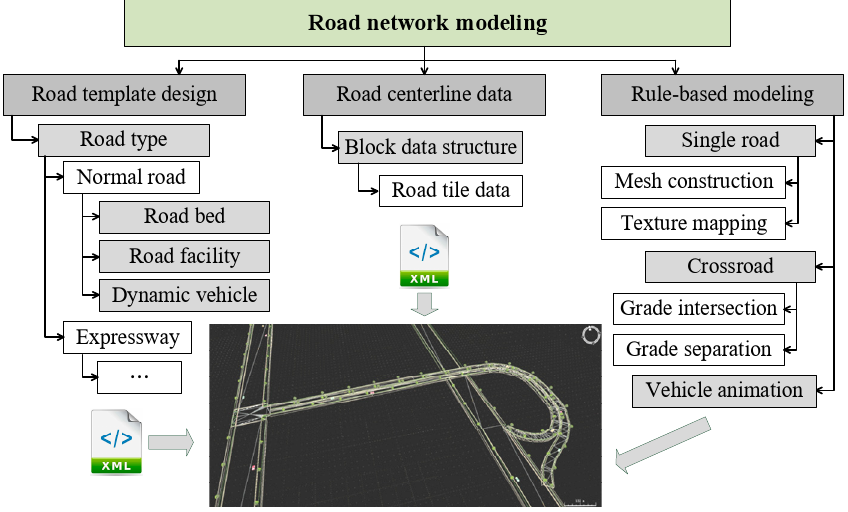
Figure 4. Road network modeling method.